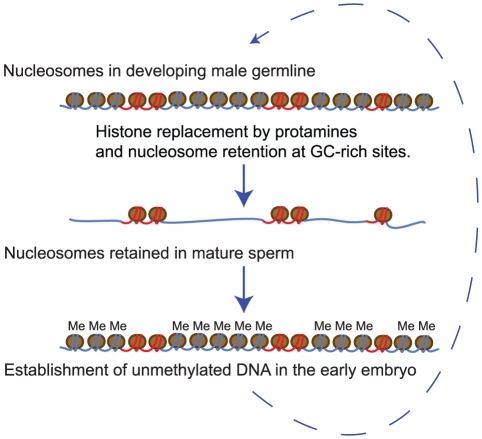
A model for nucleosome retention in human sperm.During the histone to protamine transition nucleosomes are retained at GC-rich sites which have high intrinsic affinity for nucleosomes. This results in nucleosome retention at the start sites of many genes, especially at the start sites of housekeeping genes and master regulators, as well as at distal regulatory elements. Regions that retain nucleosomes in sperm are also frequently established as free from DNA-methylation (‘Me’) in the early embryo, further suggesting a connection between the transmission of paternal nucleosomes and the establishment of gene regulation in the early embryo.